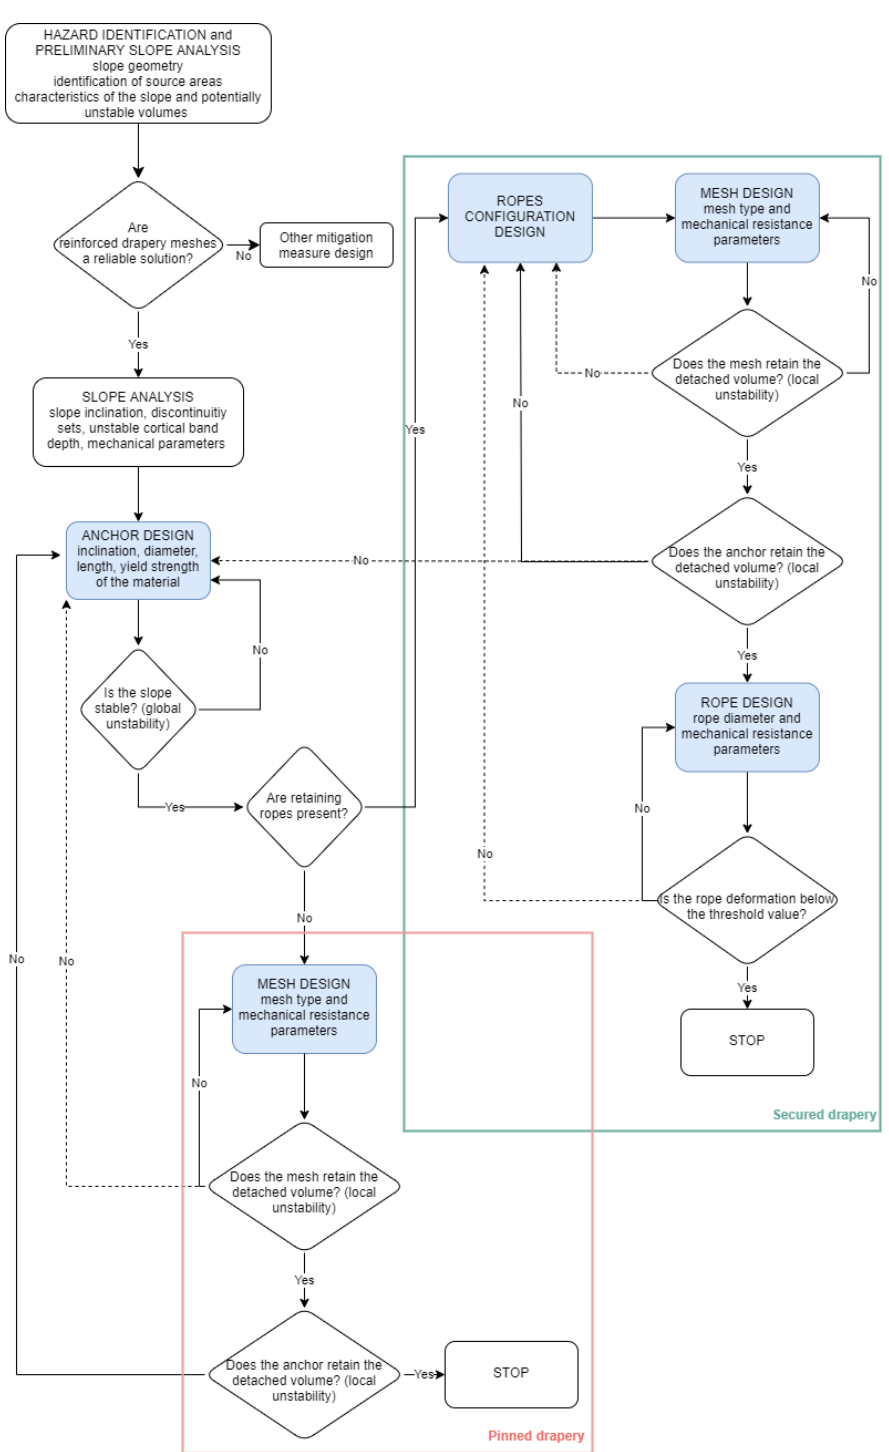
Figure 3. Flowchart for the design of reinforced drapery meshes, either pinned or secured. Dashed lines represent alternative